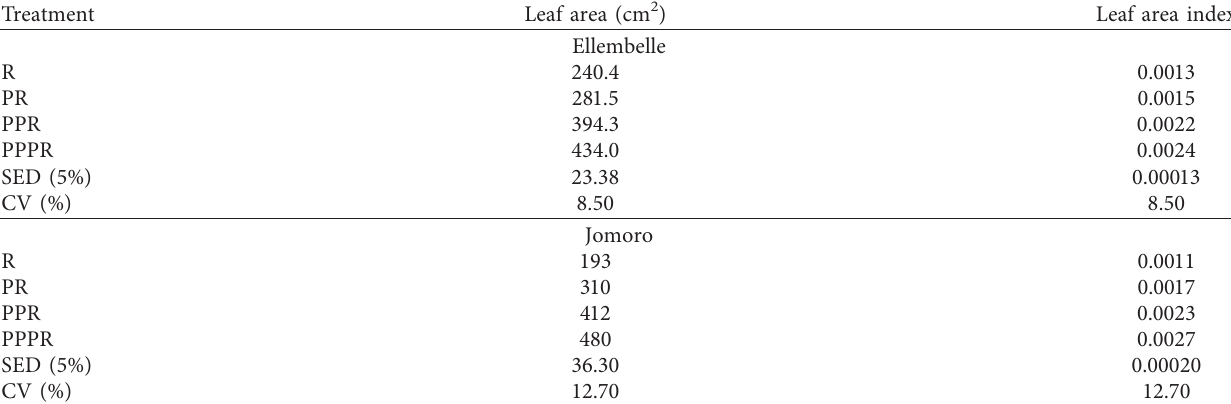
Table 10: Effect of different plantain populations on leaf area and leaf area index of rubber at Ellembelle and Jomoro. Treatment